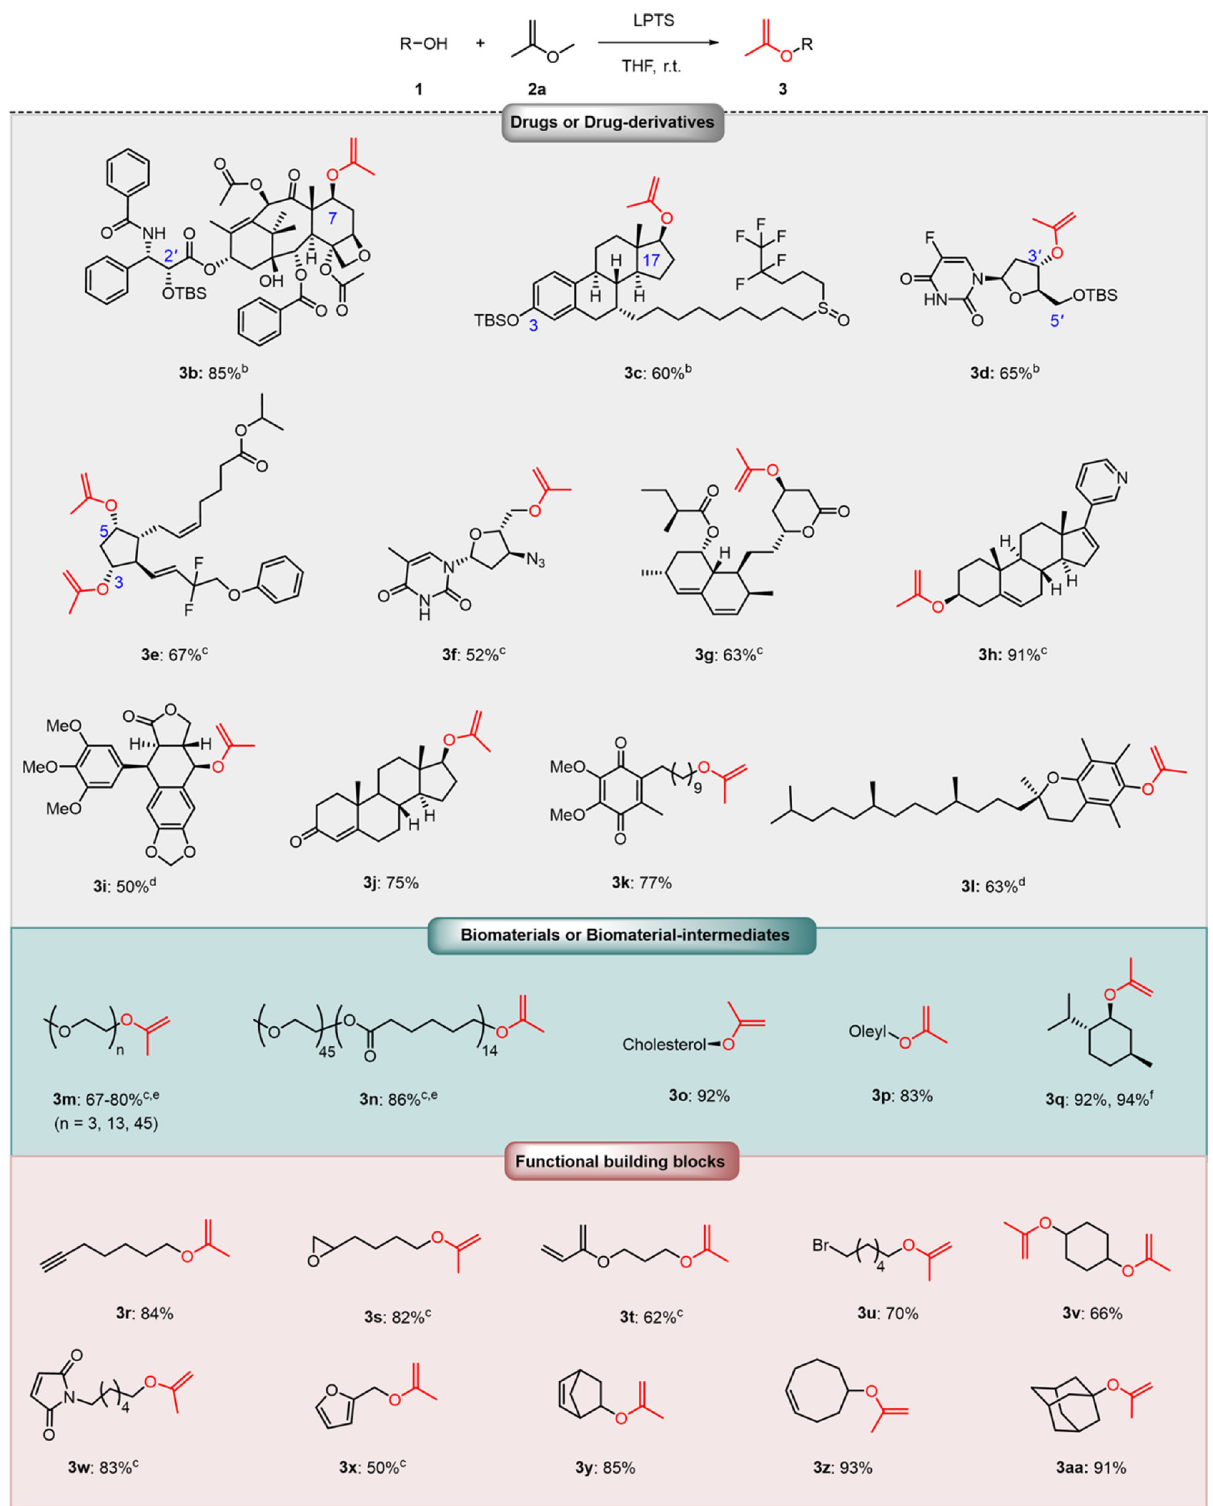
Fig. 2 Synthetic scope of alcohols a . a Reaction conditions: 1 (1.0 equiv.), 2a (16.0 equiv.), 0.5 mol % LPTS, THF, 25 o C, 12 h. b 20.0 mol % LPTS, 48 h. c 2.0 mol % LPTS, 24 h. d 5.0 mol % LPTS, 48 h. Yields of isolated products are given. e Purity of 3 is provided, as determined by 1 H NMR. f Large scale synthesis: 50 mmol 1 , isolated yields by